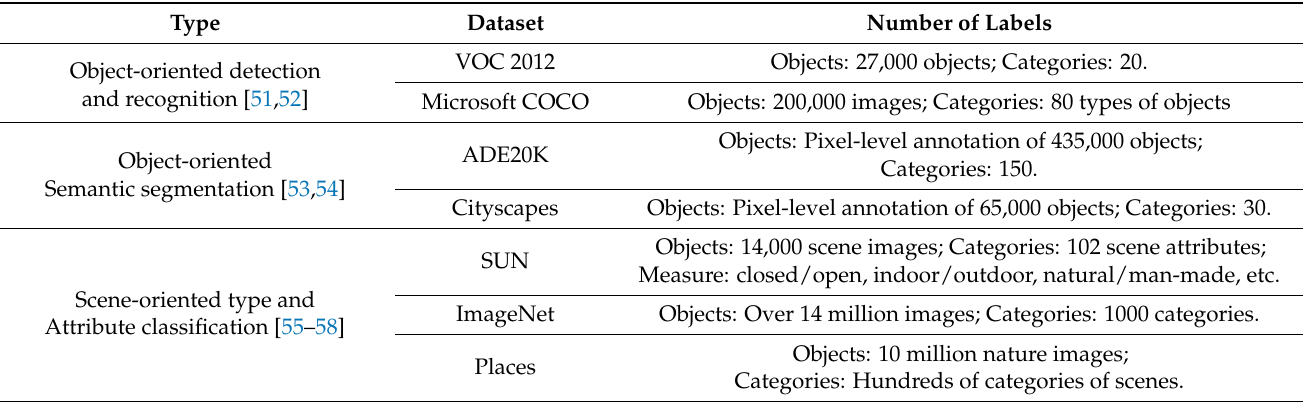
Table 3. Major open-source training